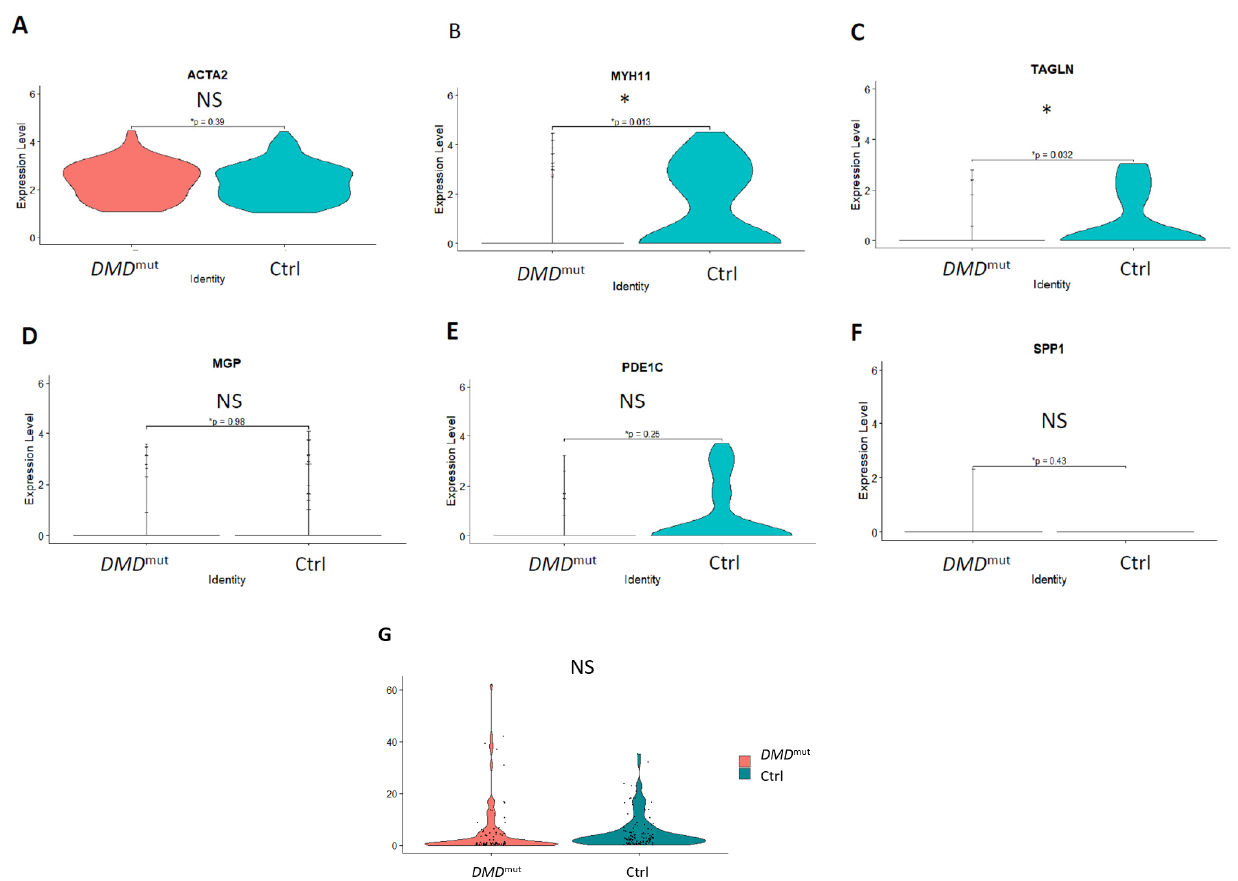
Figure 6. Violin plot illustrations of the contractile and synthetic gene marker analyses for ACTA2- annotated pan-VSMCs from DMD mut and control muscles. ( A ) The expression of ACTA2 gene between VSMCs from individual cells with DMD mutations and control muscles. ( B , C ) The expres- sion of contractile gene markers (MYH11 and TAGLN) between VSMCs from individual cells with DMD mutations and control muscles (* p < 0.05). ( D – F ) The expression of synthetic gene markers (MGP, PDE1C, and SPP1) between VSMCs from individual cells with DMD mutations and control muscles (NS: no significant difference). ( G ) The expression level of percentage of mitochondrial genes between VSMCs from individual cells with DMD mutations and control muscles (NS: no significant